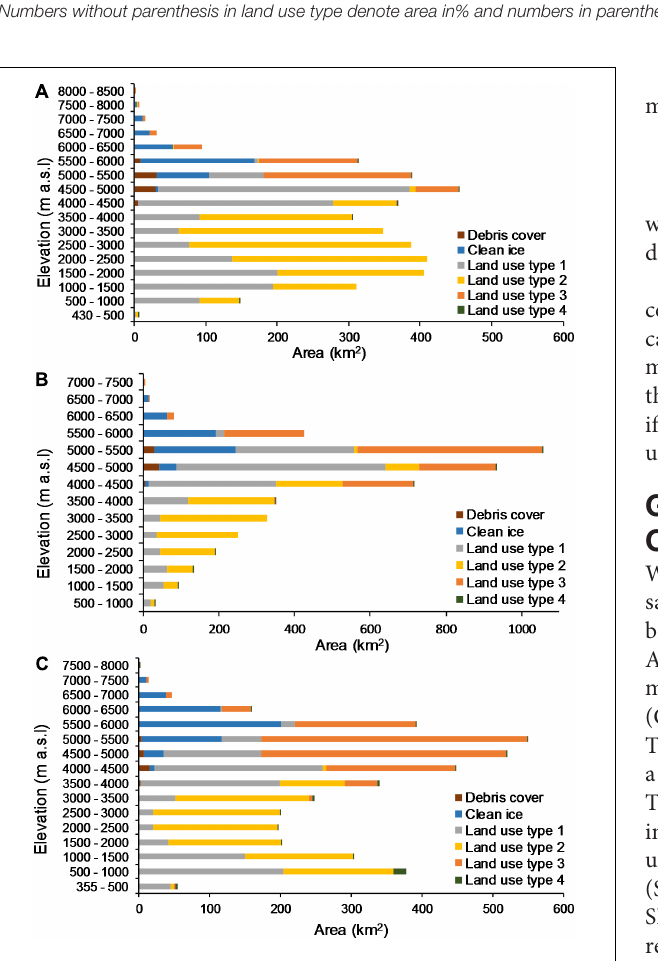
where n is the number of days, Q obs is the daily observed discharge, Q sim is the daily simulated discharge, and Q avg is the average observed